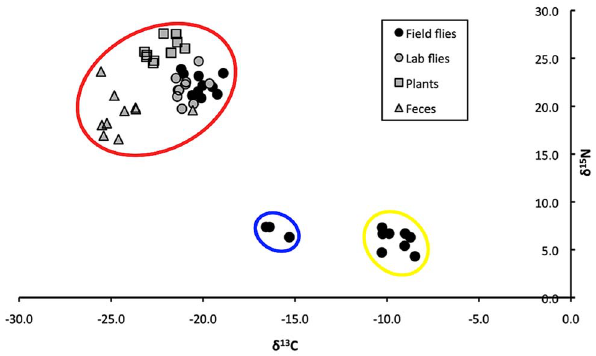
Figure 2. Stable carbon and nitrogen isotope ratios ( d 13 C and d 15 N) of feces of wild jirds, tissue of the plant fed on by jirds, and individual wild adult sand flies that had been collected near jird burrows or reared in the laboratory as larvae on field- collected jird feces. Hierarchical cluster analysis identified 3 significantly different groups of samples based on d 13 C and d 15 N values. The cluster circled in red contained feces of wild jirds, tissue of the plant fed on by jirds, individual sand flies reared in the laboratory as larvae on field-collected jird feces, and 50.0% of the sand flies captured near the jird burrows. The clusters circled in blue and yellow contained 36.4% and 13.6% of the sand flies captured near the jird burrows, respectively.